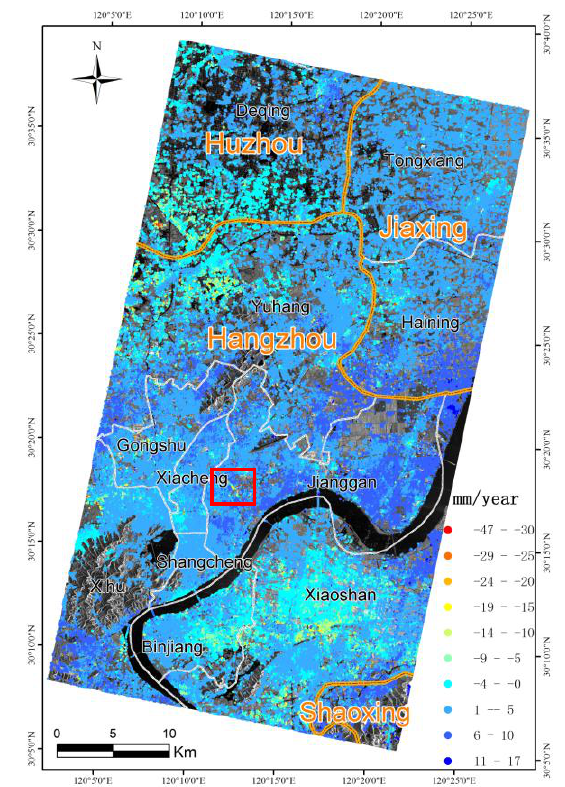
Figure 3. Average subsidence velocity in Hangzhou (2012- 2015). The red block is the coverage of Figure